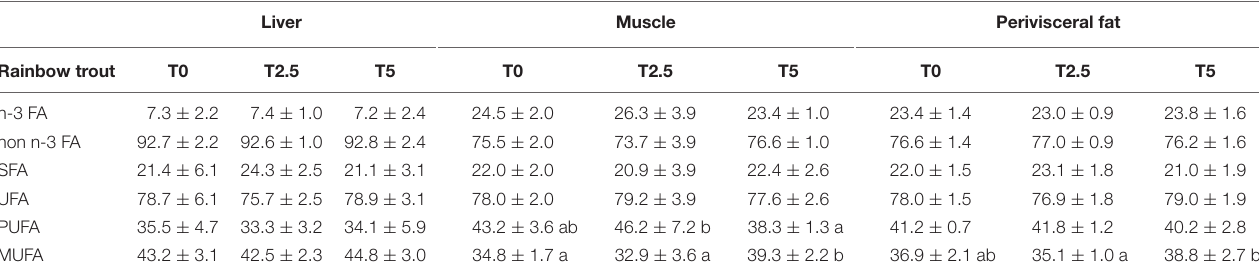
TABLE 2 | Percentage of fatty acid classes as determined from 1 H NMR spectra of TAG from liver, muscle and perivisceral fat of rainbow trout ( Oncorhynchus mykiss ) fed with different levels of glycerol (0, 2.5, and 5%). Liver Muscle Perivisceral fat